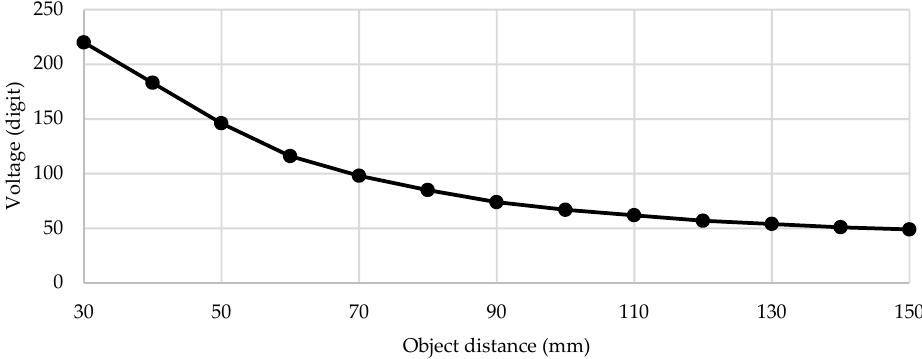
Figure 11. Measured voltage/distance characteristics of the distance measurement subsystem.